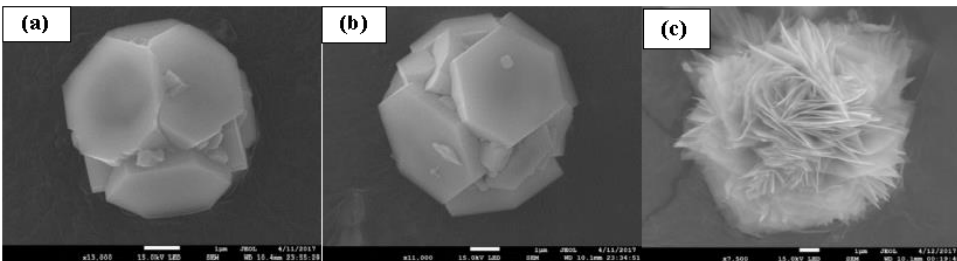
Figure 11. SEM images of T-7F hydrothermally prepared at various temperatures: ( a ) 150, ( b ) 170, and ( c ) 200 ◦ C